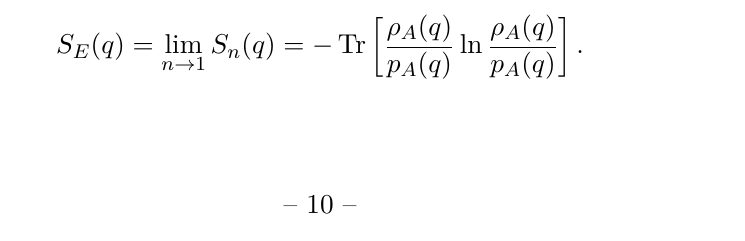
λ i . Right: λ i , the continuous i =1